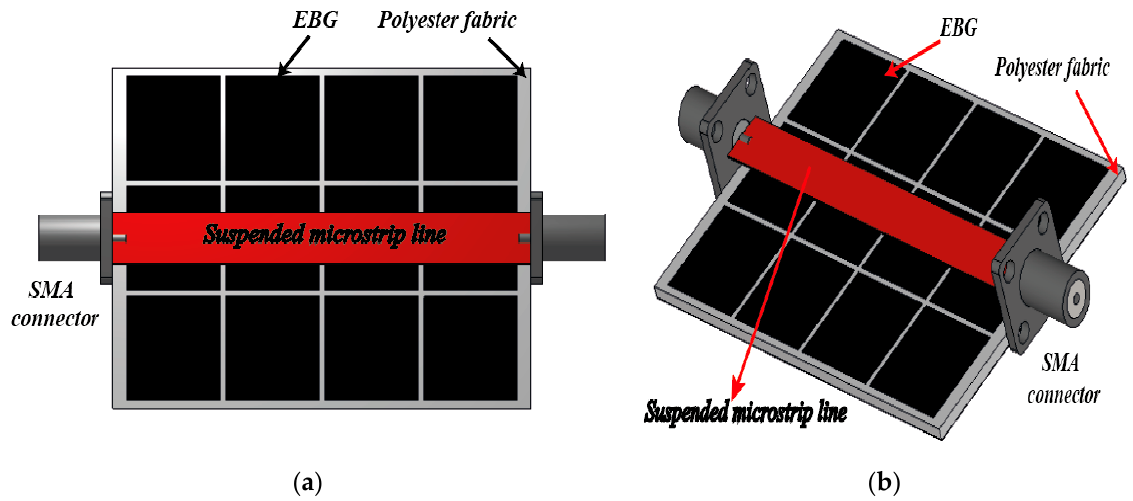
Figure 6. Suspended microstrip line method of EBG: ( a ) top view; ( b ) 3-D view.